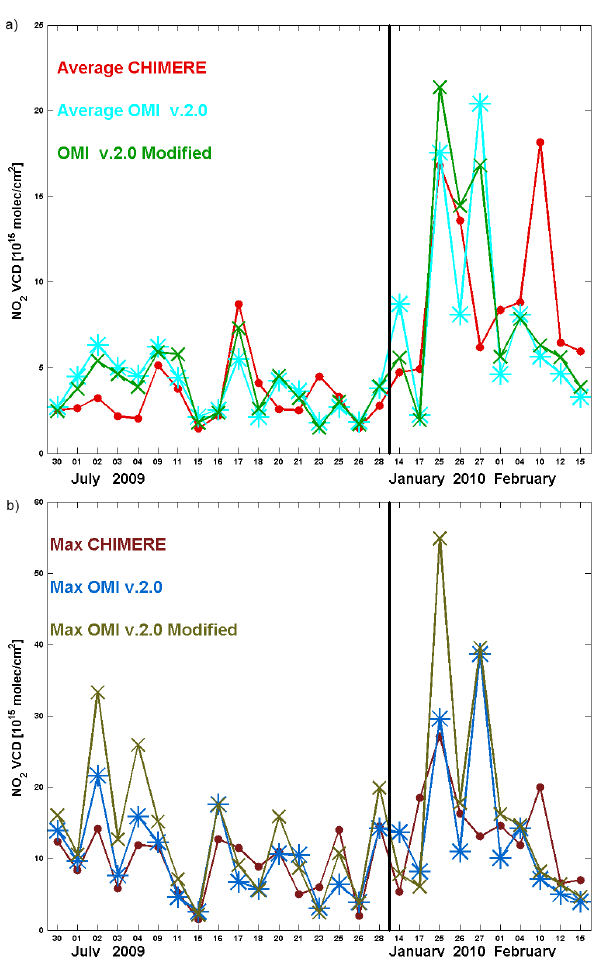
Figure 18. Comparison of the daily average (a) and maximum (b) tropospheric NO 2 VCDs for original and modified OMI observa- tions (CF below 30%) and coincident CHIMERE